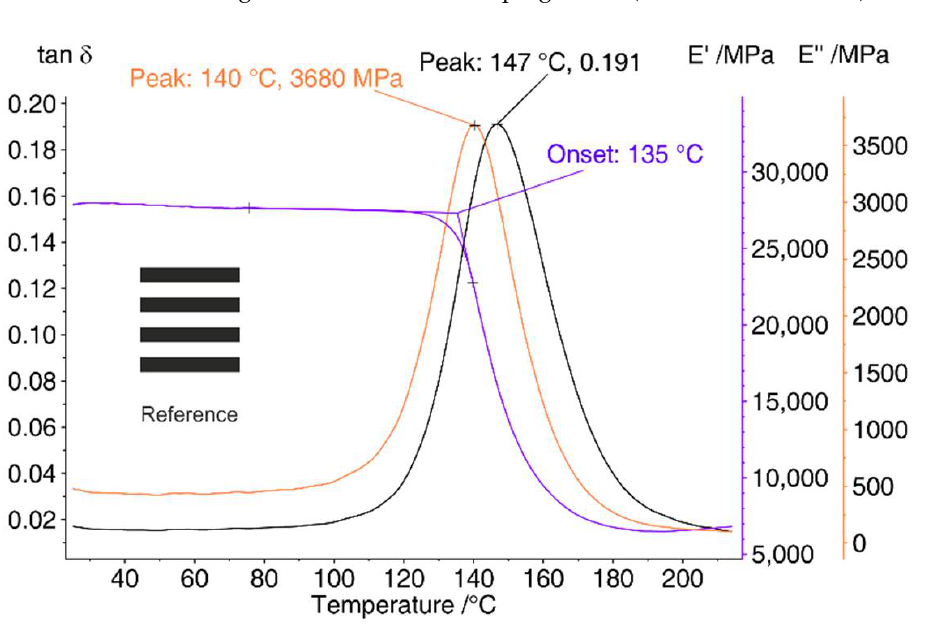
Figure 5. DMA of reference laminate (C-Ref): E′ (purple), E″ (orange), tanδ (black). For the nano-modified samples, only the tan δ profile will be reported, as the tan δ behaviour is the focus of the present